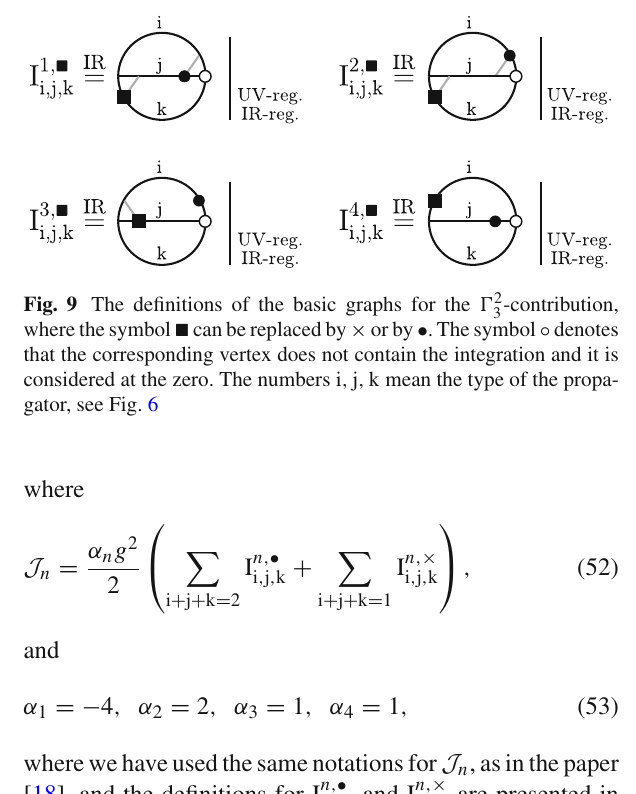
Fig. 8 Diagram equalities, where the function q, such that q ( • ) = 0 and q ( × ) = 1, shows the degree of the background field in the corre- sponding vertex. The symbol ◦ denotes that the corresponding vertex